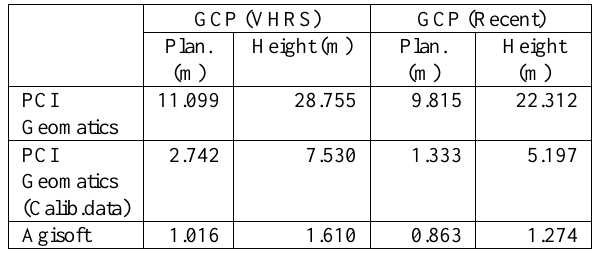
Table 7. Geometric accuracy using NEX7